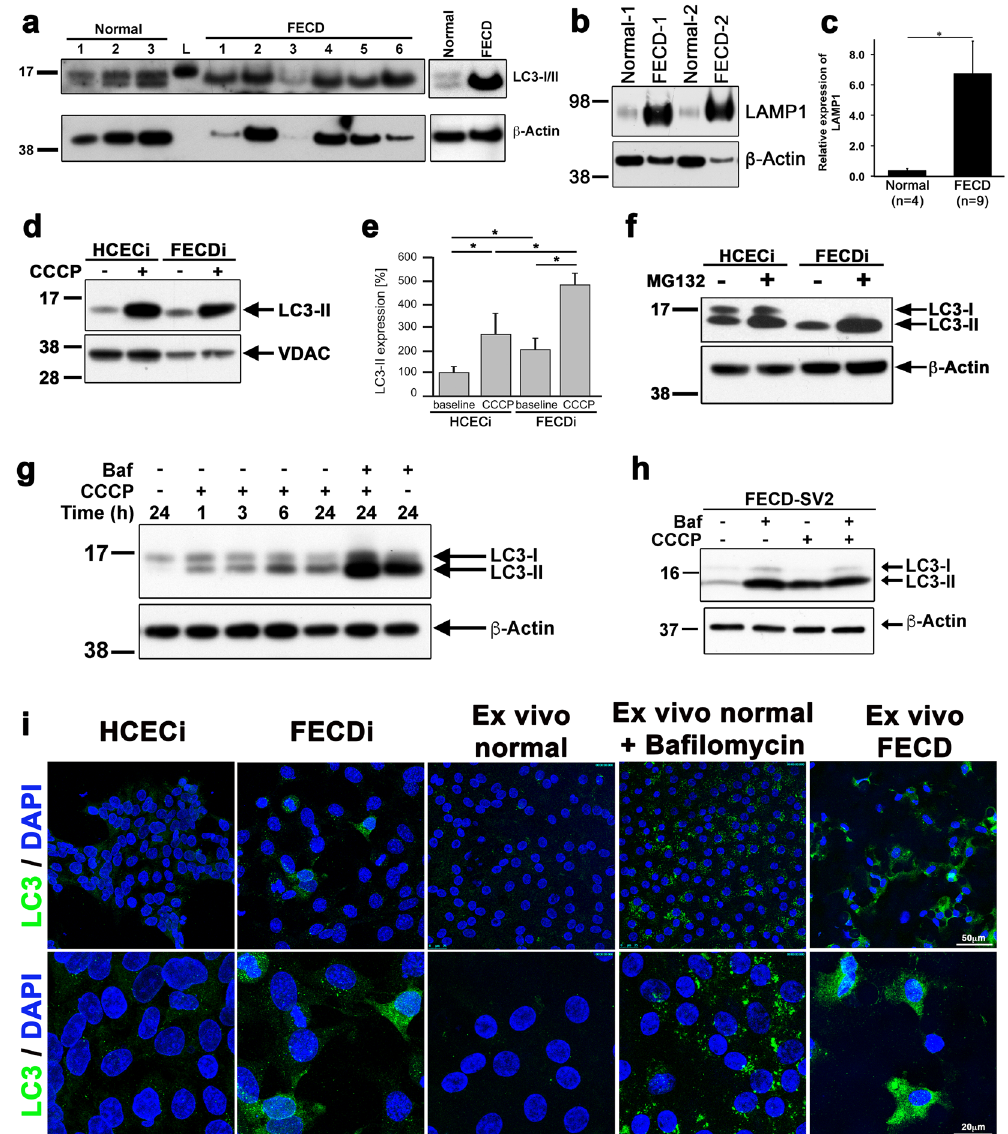
Figure 2. Autophagy marker LC3-II to –I ratio is increased in FECD. ( a ) LC3-I to LC3-II protein expression was compared between normal (n = 3) and FECD (n = 6) specimens. Normal specimens expressed both LC3-I and –II, whereas LC3-I was not detected in FECD specimens. LC3-II was markedly higher in FECD specimens indicating an increased activation of autophagy. ( right ) Western blotting of an independent normal and FECD specimen shows elevated LC3-II levels with the absence of LC3-I. ( b ) Normal and FECD specimens tested for the expression of the lysosomal marker LAMP1 and quantified in ( c ). ( d ) Western blotting of mitochondrial fractions from HCECi and FECDi cells treated with CCCP probed for LC3 shows increased LC3-II in FECDi that is further activated with CCCP. ( e ) Quantification of LC3 in ( d ) normalized with VDAC. Bars represent the average ( + SEM) of normalized LC3-II from three independent experiments. ( f ) HCECi and FECDi were exposed to the proteasome inhibitor 50 μ M MG132 for 6 hours. LC3-II expression was increased in FECDi compared to HCECi, indicating autophagy pathway is activated after inhibition of the proteasome. ( g ) Treatment of HCEnC-21T cells with 20 μ M CCCP shows a time-dependent increase in conversion of LC3-I to LC3-II. Inhibition of the fusion of autophagosome with lysosome with 10 nM bafilomycin leads to the accumulation of LC3-II that is further exacerbated when combined with CCCP. ( h ) Western blot of FECD-SV2 lysates show increased LC3-II that is upregulated with bafilomycin and CCCP. ( i ) Confocal micrographs showing immunolocalization of LC3 in HCECi and FECDi suggests increased LC3 in FECDi. A normal donor cornea was cut into two halves were either untreated or treated with 10 nM bafilomycin for 16 h. Increased LC3 staining was seen in the bafilomycin treated specimen (positive control). FECD ex vivo specimen showed increased LC3 with higher intensity compared to the positive control suggesting increased autophagy in FECD. Student’s t -test was performed to test the statistical significance. * P < 0.05 and ** P <